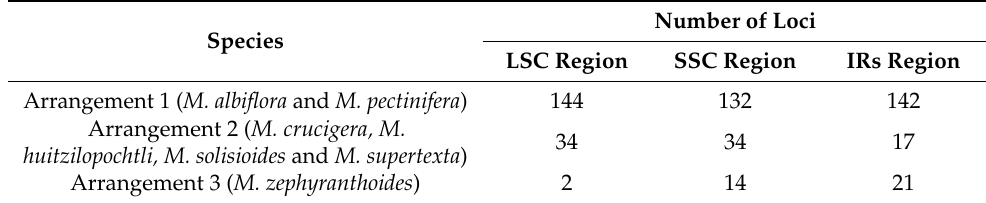
Table 2. Distribution of the 180 homologous loci identified in the seven Mammillaria species. The number of loci in each structural region of the chloroplast genome is shown.